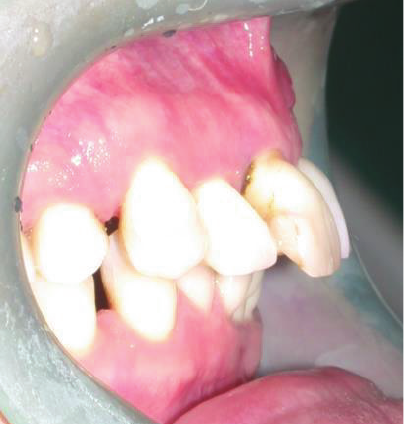
Figure 2: Right side view of patient upon presentation.